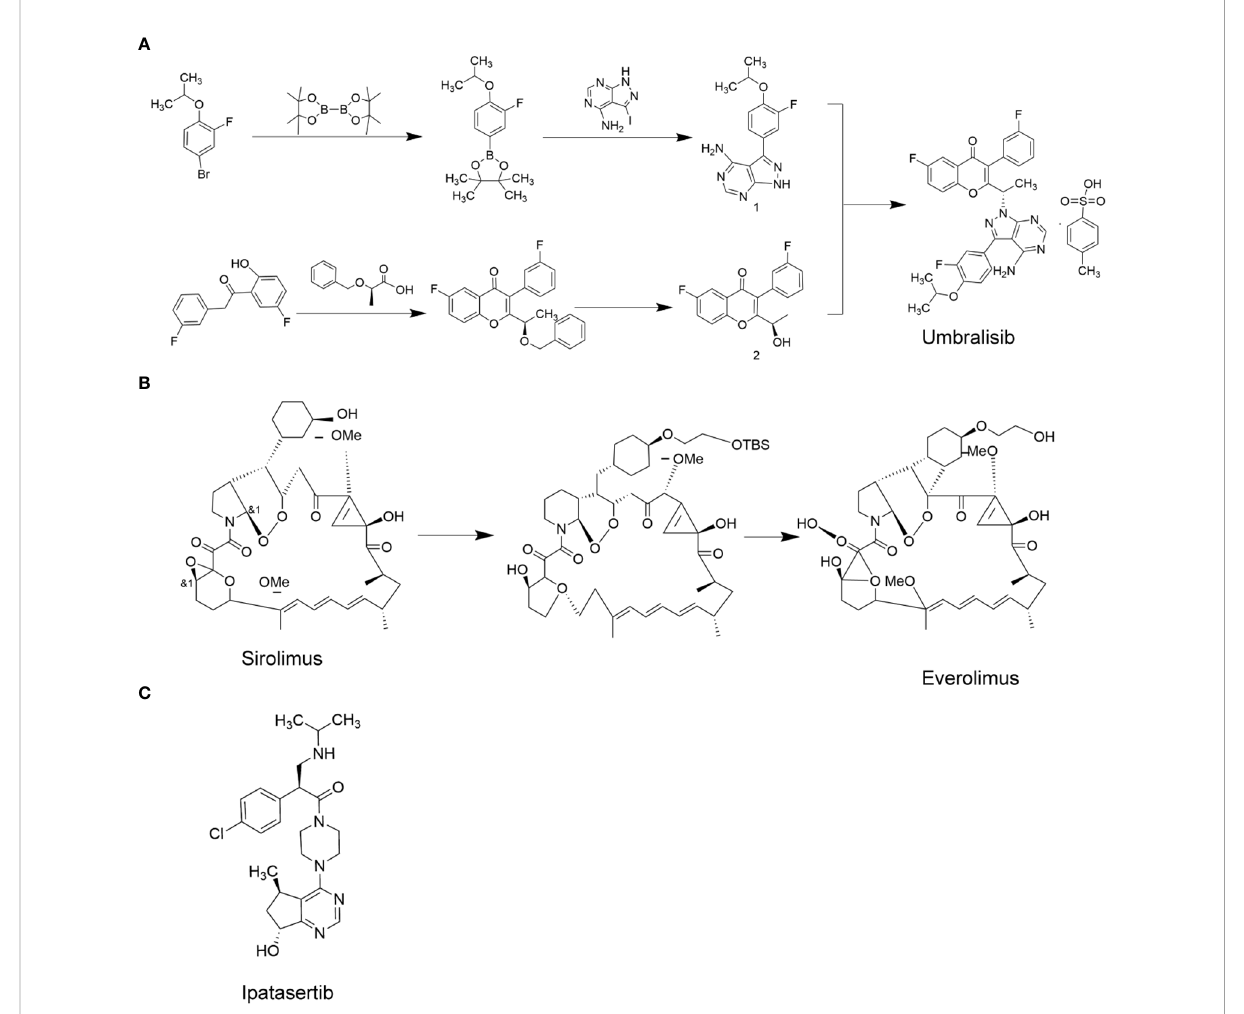
FIGURE 4 PI3K/AKT/mTOR target-related chemotherapy drugs. (A) , Umbralisib; (B) , Everolimus; (C) , Ipatasertib.